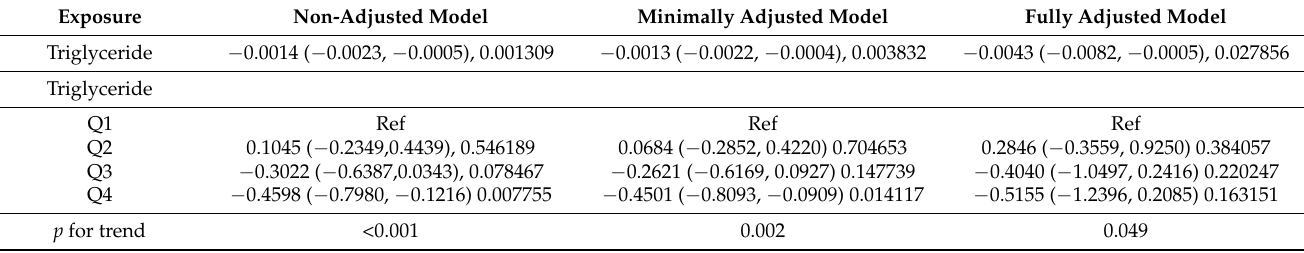
Table 2. Univariate and multivariate analyses by the weighted linear